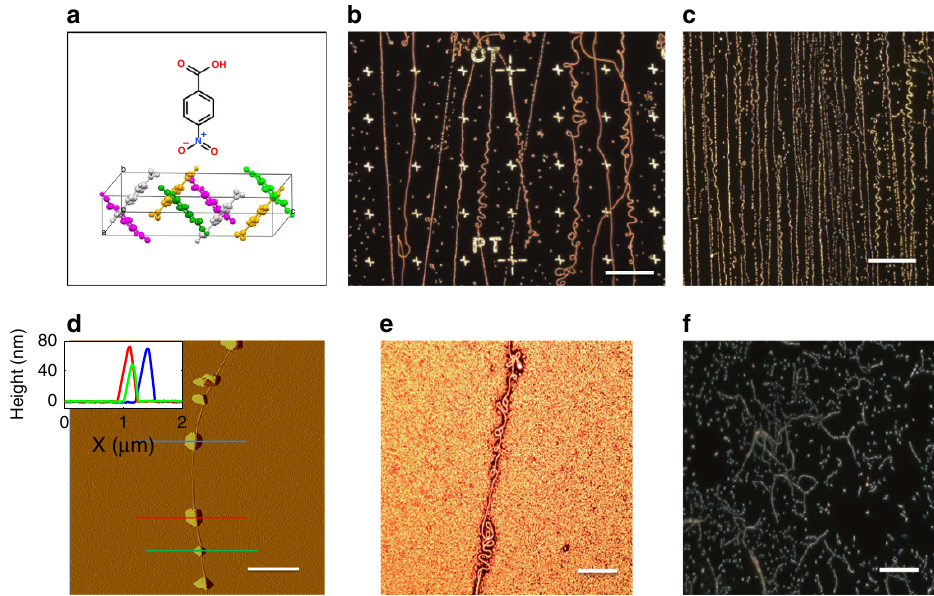
Figure 1 | Preferentially adsorption of p -nitrobenzoic acid on carbon nanotubes. ( a ) Top: Chemical structure of p -nitrobenzoic acid ( p NBA). Bottom: Schematic illustration of the monoclinic unit cell of p NBA powder as extracted from X-ray diffraction analysis. ( b , c ) Dark field optical microscopy images of p NBA nanocrystals adsorbed along CVD grown carbon nanotubes (CNTs). Scale bar, 50 and 20 m m, respectively. ( d ) Amplitude image of AFM of a single CNT with a few p NBA nanocrystals along. Scale bar, 1 m m. Inset: height cross sections along the marked lines of the main figure. ( e ) Dark field optical microscopy image of p NBA nanocrystals after intensive deposition. Note the black voids along the CNT. Scale bar, 20 m m. ( f ) Dark field optical microscopy image of p NBA nanocrystals adsorb onto commercial dispersed CNTs. Scale bar, 20 m